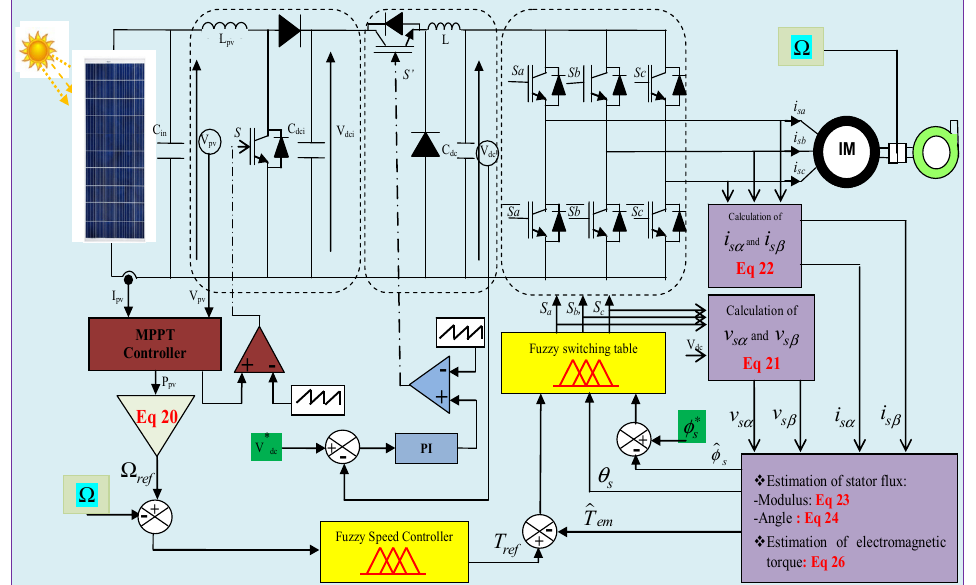
Figure 4. Synoptic control scheme of proposed PVWPS.